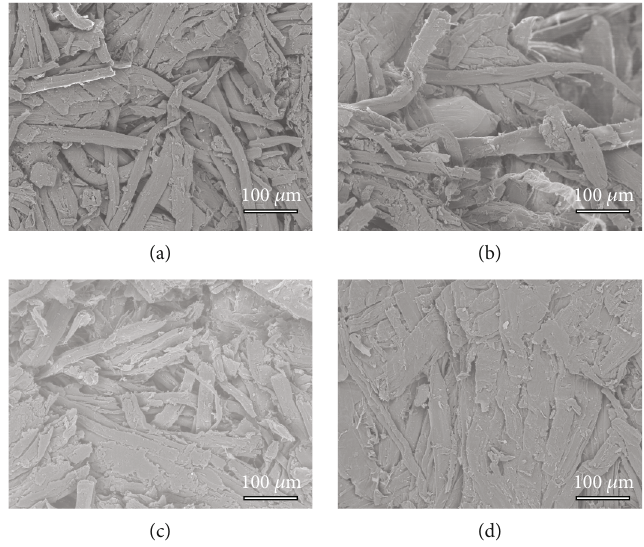
Figure 2: Top view SEM images: (a) F-W; (b) F-DHF; (c) F-CS; (d)